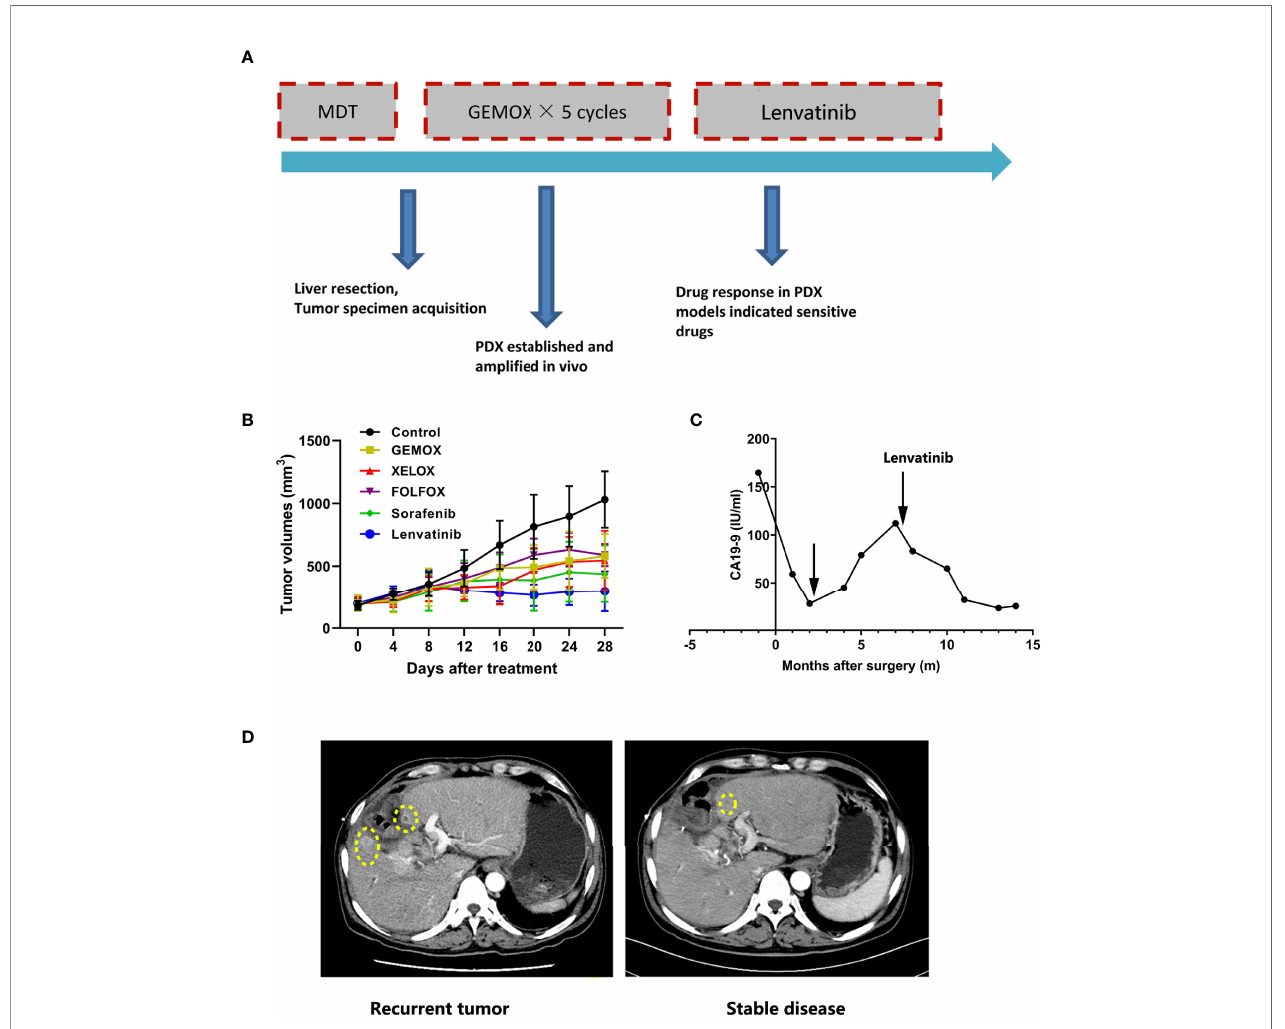
FIGURE 3 | The PDX model guide personalized treatment for ICC patients. (A) Summary of clinical history for IMF-138; (B) PDX models showed diverse treatment response to various treatment regimens; (C) Human CA19-9 levels were observed during the clinical course; (D) The representative CT images for patient who received lenvatinib